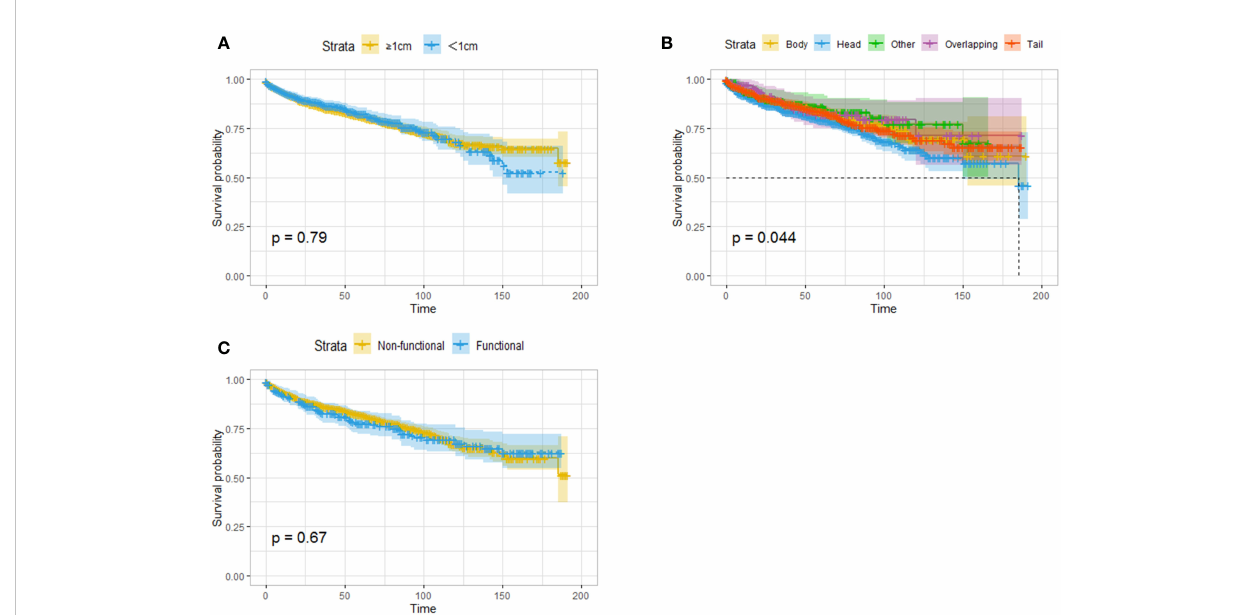
FIGURE 2 Survival analysis (OS) based on the size of tumor (A) , the location of the tumor (B) and the functional status (C) . Tumor size and endocrine function were not associated with survival, and the patients with pancreatic head tumors had worst